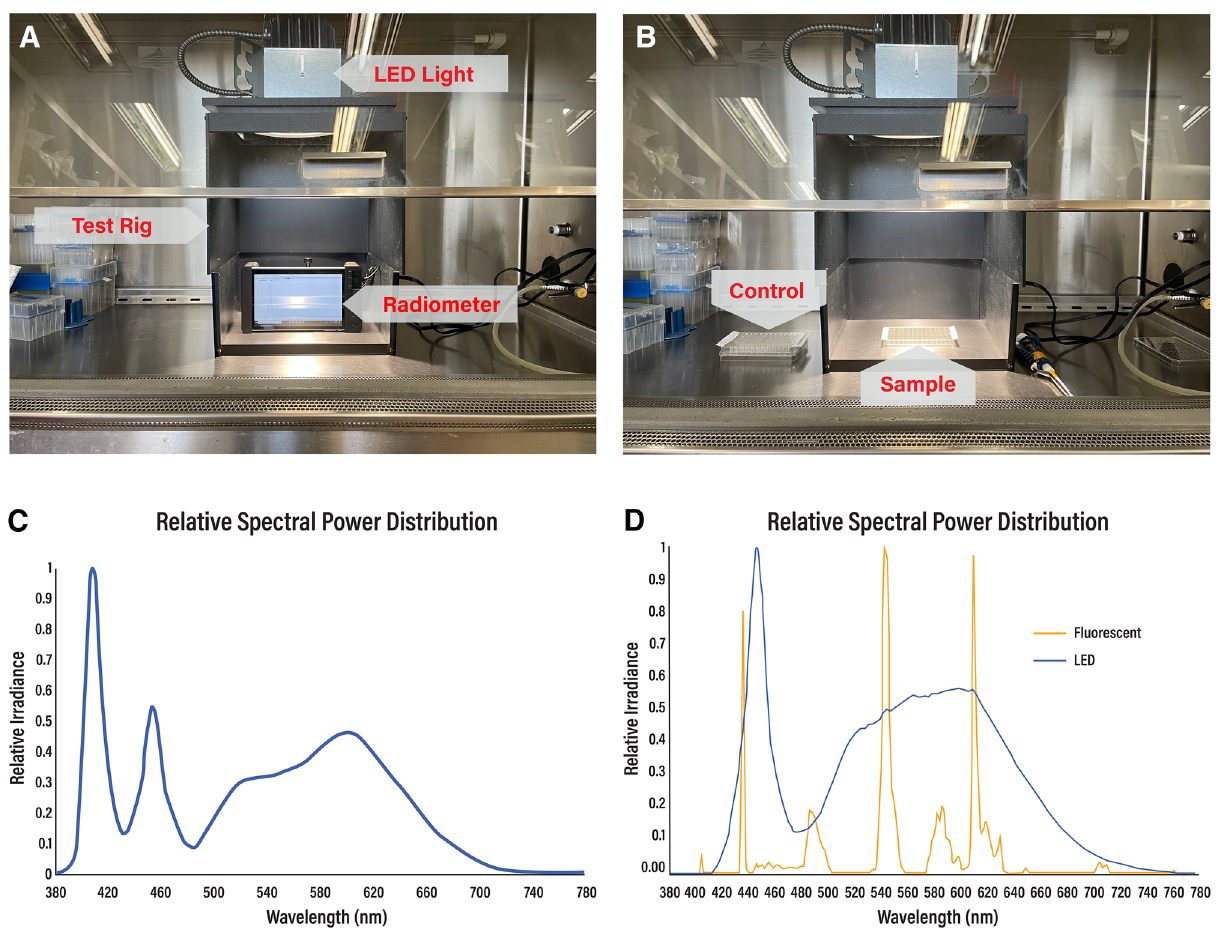
Figure 1. Inactivation device setup and characterization. ( A ) Test setup shown with spectroradiometer, and extension used for calibration. ( B ) Test setup showing the placement of the control and sample for irradiation. The bottom portion of the test rig was removed during the actual experiment to ensure the 10 ″ distance used in the study. ( C ) Normalized spectral power distribution showing peak irradiance at 405 nm. ( D ) Normalized spectral power distribution for the fluorescent control light (non-disinfecting) and standard LED light (without 405 nm) used in the study. Each spectrum is normalized relative to its own peak